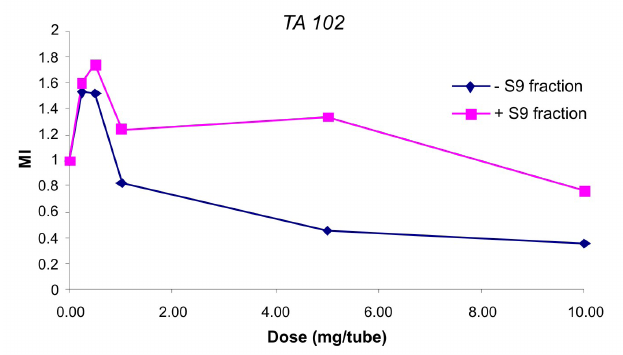
FIGURE 4 - Mutagenic Index (MI) as a function of dose (mg/ tube) of “barbatimão” extract (BE), with or without S9 fraction on TA102. The maximum coefficient of variation (CV) of experiments was 10%. Plots represent the average of four independent experiments.